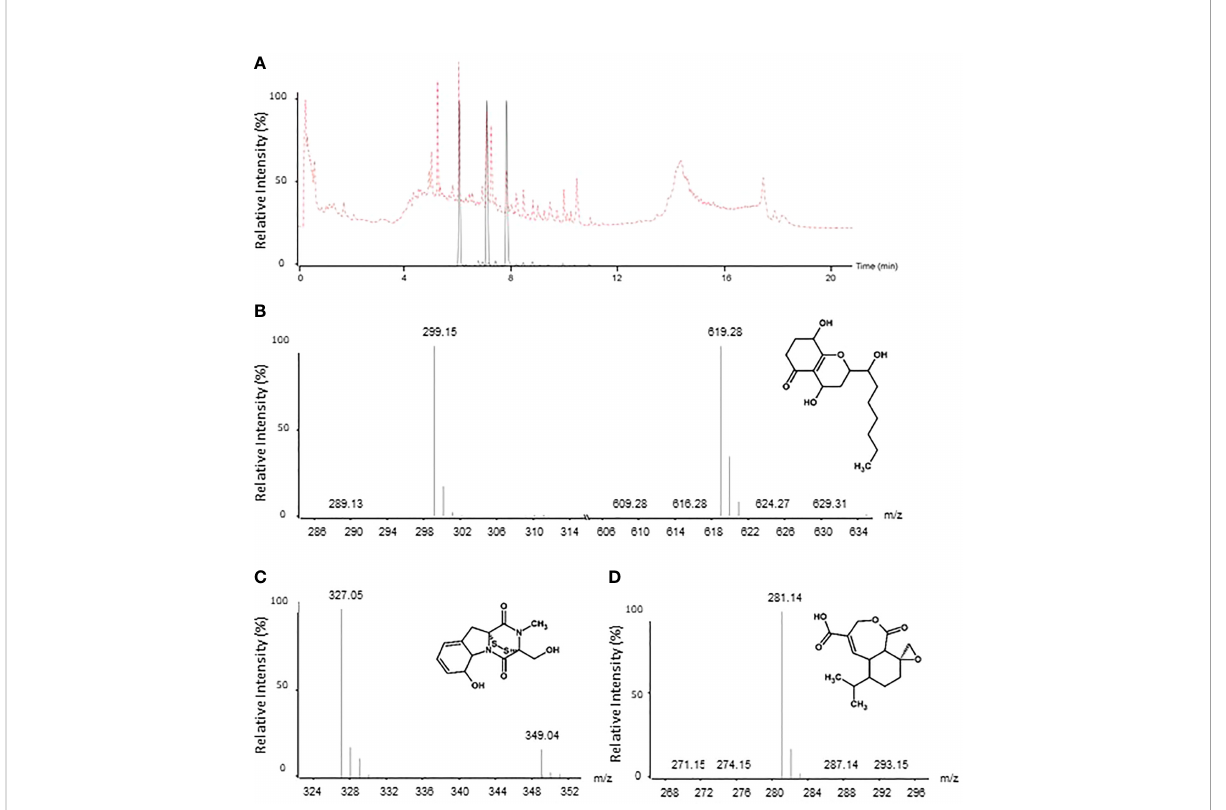
FIGURE 6 LC-MS analysis of T. virens MUCL 18139 fi ltrate. Overlay of extracted ion chromatograms (EIC) of three potential molecules involved in the bioactivity of T. virens MUCL 18139 (black). Total ion current (TIC) is represented in the dotted red line (A) . Mass spectra and structures of the tree potential metabolites detected in fi ltrate: koninginin D (RT = 6.1 min): [M+H] + =299.15; [2M+Na] + =619.28; gliotoxin (RT = 7.2 min): [M +H] + = 327.05; [M+Na] + =349.04 and koningic acid (RT = 7.9 min): [M+H] + =281.14 ( B – D ,